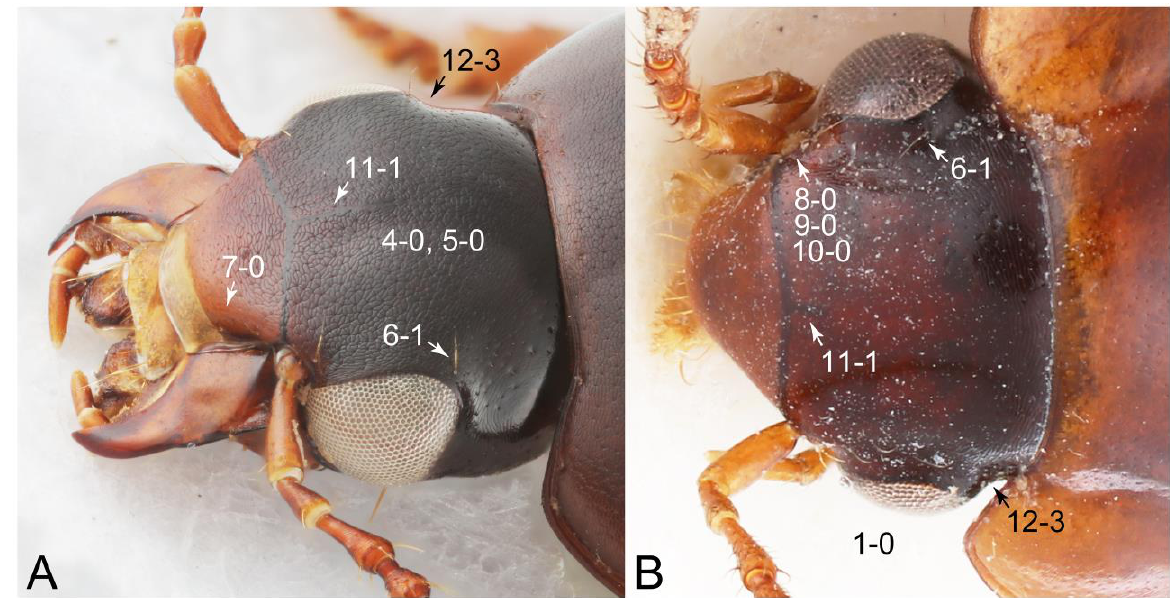
Figure 50. Photographs of body parts of Tachinusini, head, enlarged. ( A ) Tachinus fumipennis , dorsolateral view. ( B ) Pseudotachinus besucheti , dorsal view. Characters and character states (format X-X) are indicated on each